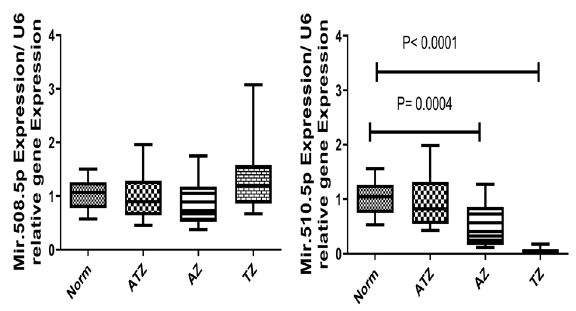
Figure 1 . Comparison of miR-508-5p (A) and miR-510-5p (B) expression in different groups. TAZ: Teratoasthenozoospermia; AZ: Asthenozoospermia; TZ: